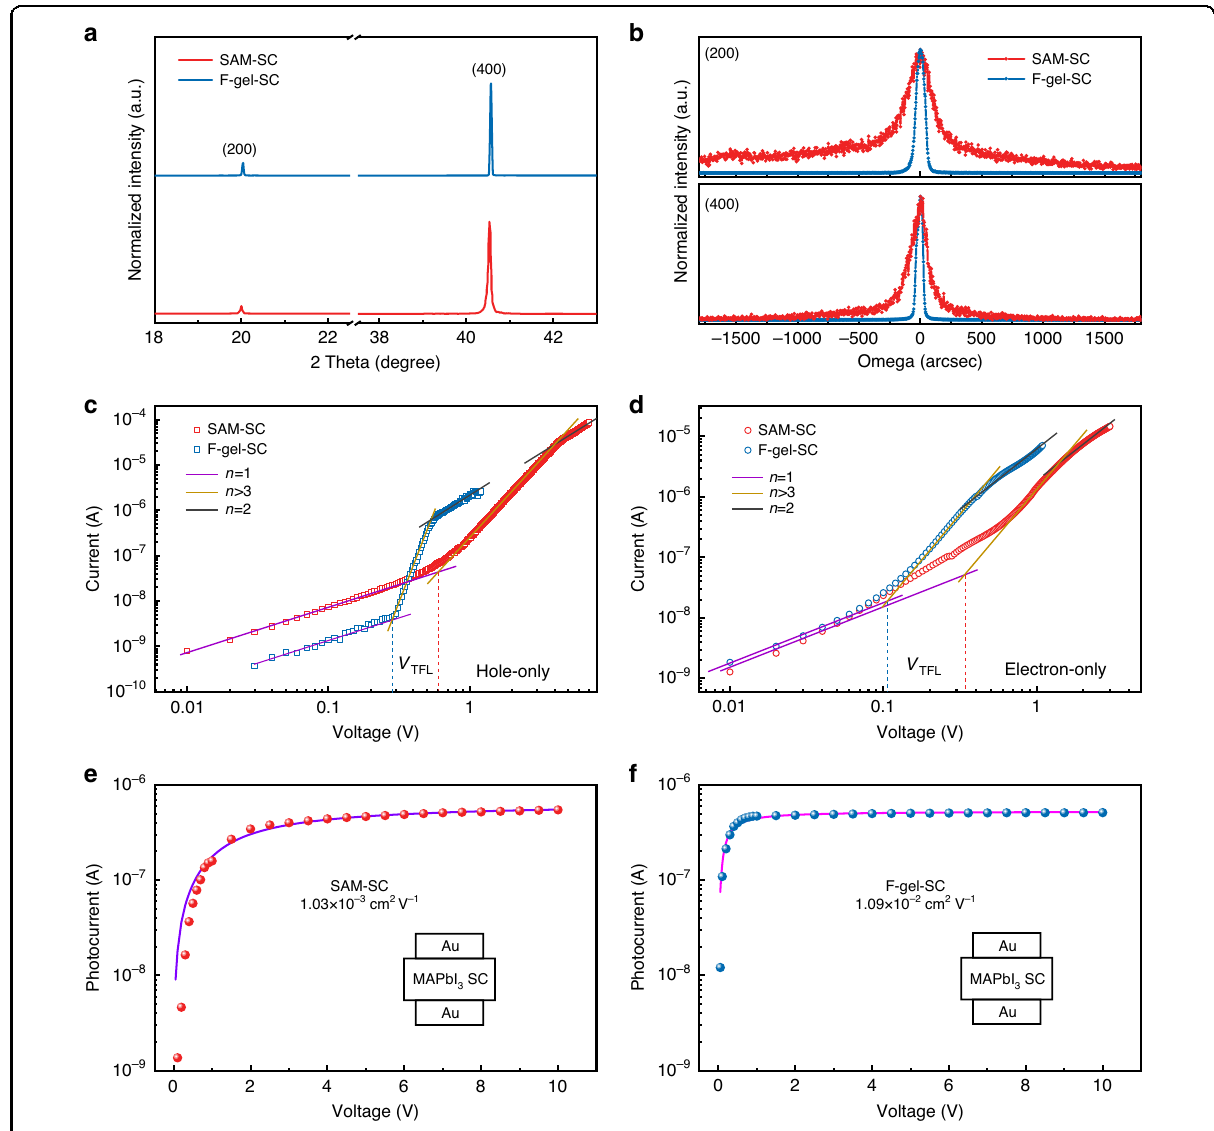
Fig. 3 Crystallinity and charge transport properties of MAPbI 3 SCs. a XRD and b XRD rocking curves for crystals grown on different substrates. c SCLC tests of hole-only and d electron-only devices for crystals grown on different substrates. The μτ product derived from the steady-state photocurrent method for crystals grown on e SAM and f F-gel